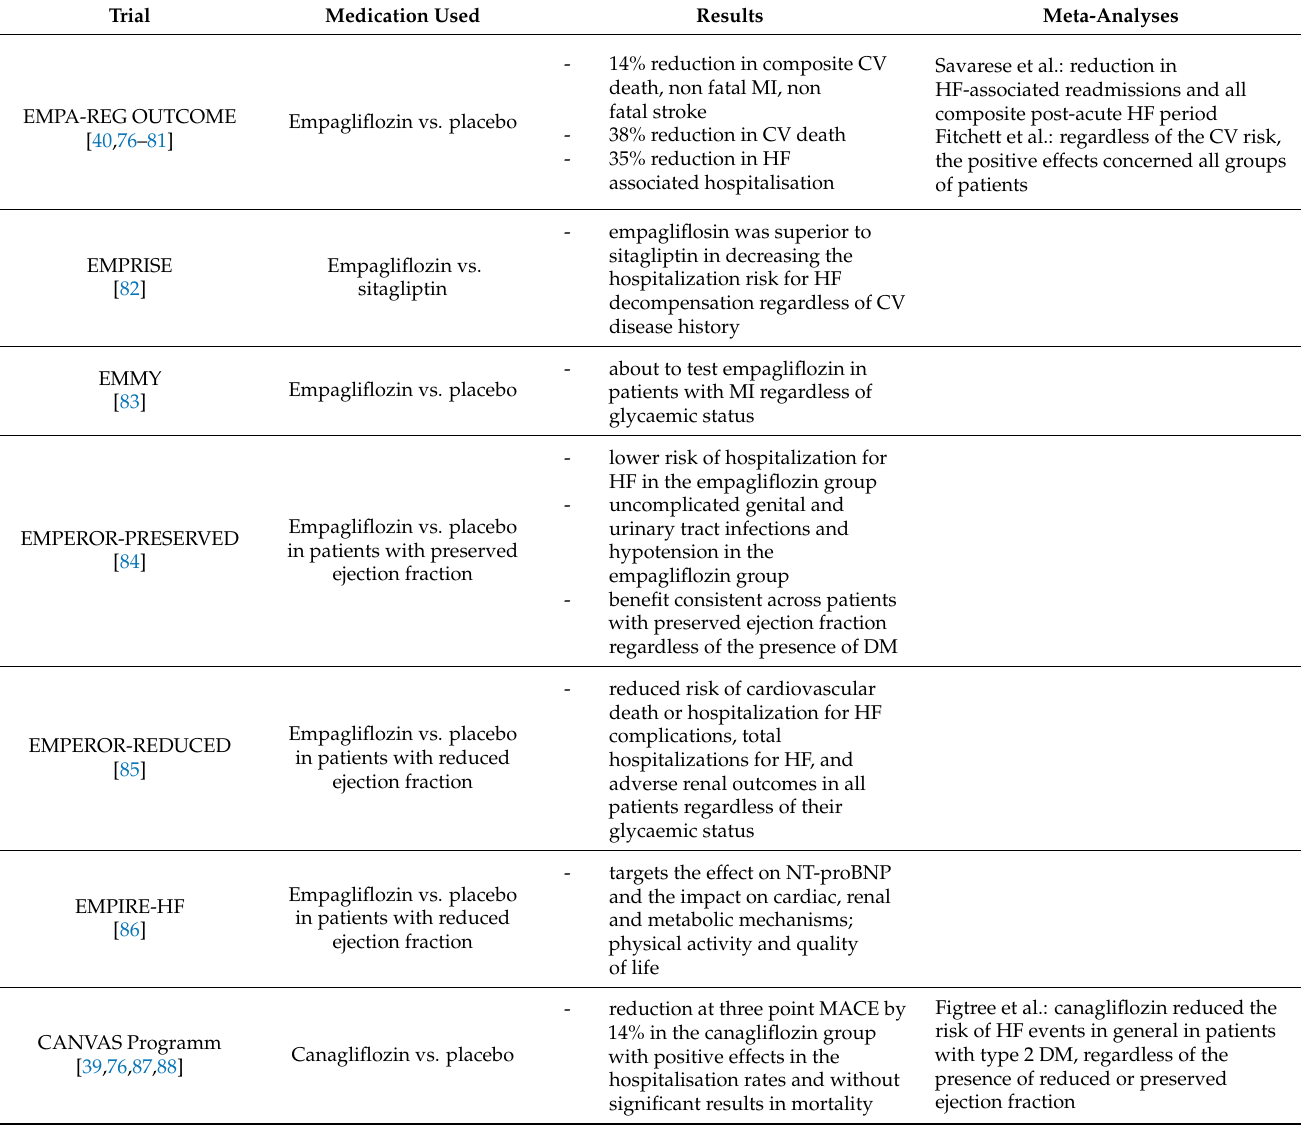
Table 2. Clinical trials studying the effect of SGLT2 inhibitors on cardiovascular outcomes and heart-failure-related events.